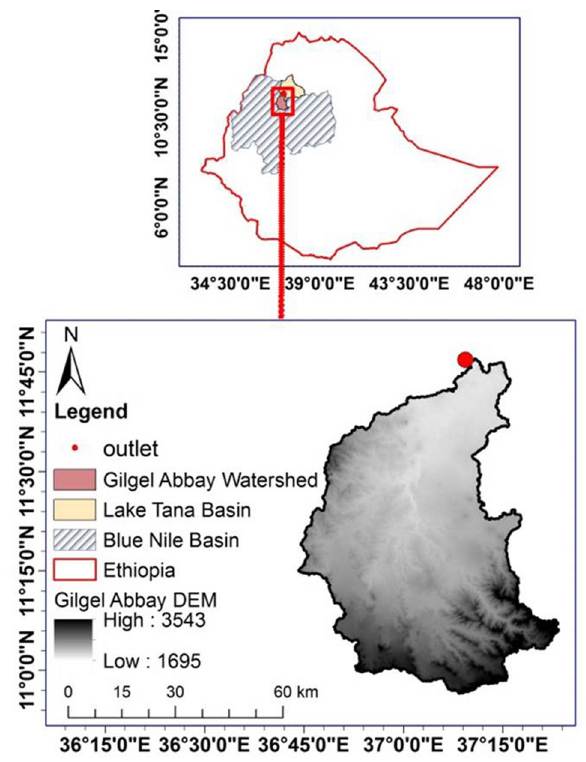
Fig. 1 Study area, Lake Tana and Blue Nile Basin and Ethiopia map ( Source: Study watershed is delineated from the DEM and the other shapefiles are obtained from the Ethiopian map server agency (http:// www. ethio gis- mapse rver. org/ about- us.